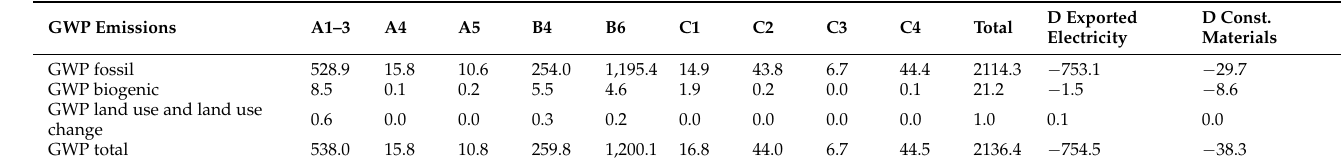
Figure 10. Climate footprint of the district as a function of time concerning four different scopes— without purchase of RECs ( a ) and with purchase of RECs ( b ). Table 6. Origin of GWP emissions in kg CO 2 eq/m 2 of net area for an RSP equal to 50